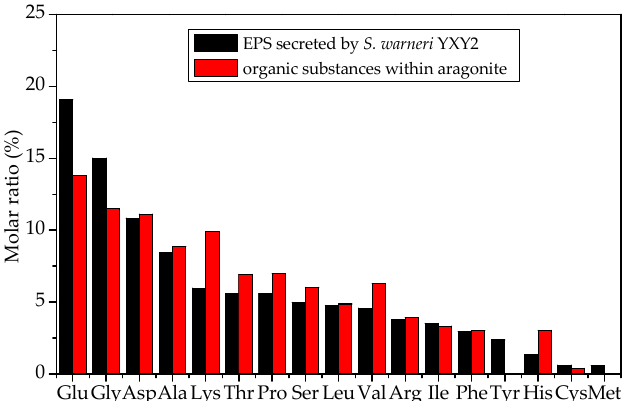
Figure 11. Amino acid composition of EPS secreted by YXY2 bacterium and that of the organic substances within the biotic aragonite minerals.